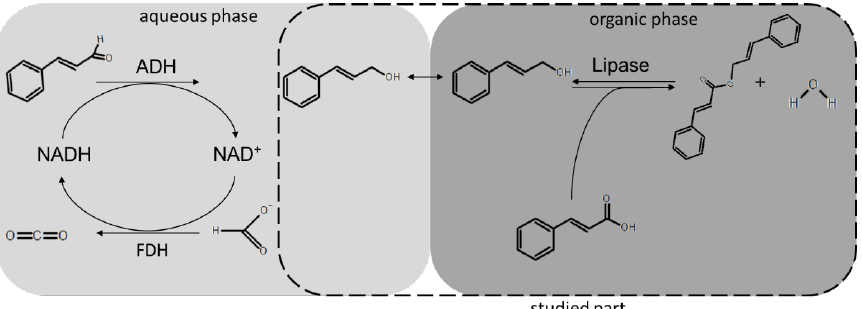
Figure 1. Reaction scheme of the multi-enzyme cascade for the production of cinnamyl cinnamate in a two-phase system .